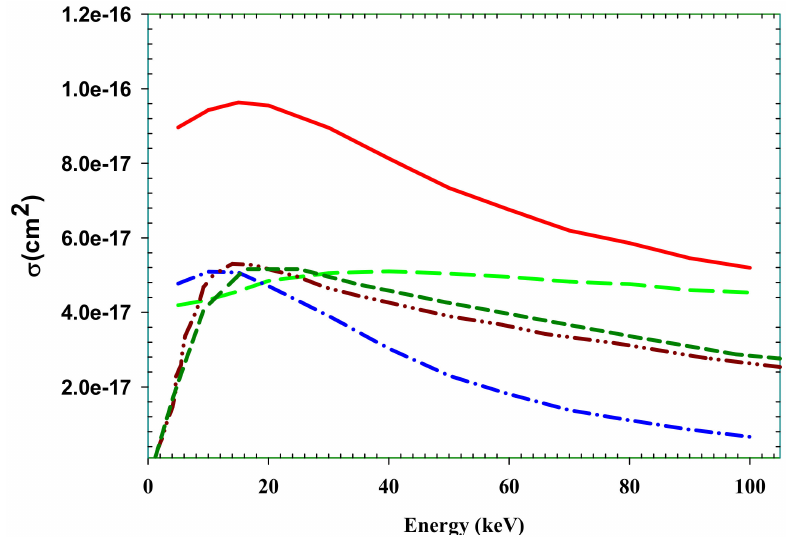
Figure 3. Target ionization cross sections in collision between two ground state hydrogen atoms as a function of impact energy. Green long dashed line: presents CTMC results for direct ionization (CTMC SI) of the target, defined by Equation (12). Blue dashed dotted line: presents CTMC results for two-step ionization of target, defined by Equation (13). Red solid line: target ionization cross sections as a result of the sum of the one-step and two-step processes (CTMC EL). Dark red double-dotted dashed line: semi-quantal calculation for direct ionization of the target by Flannery [17]. Dark green short dashed line: Born calculation for the ionization of the target by Bates and Gri ffi ng [18].